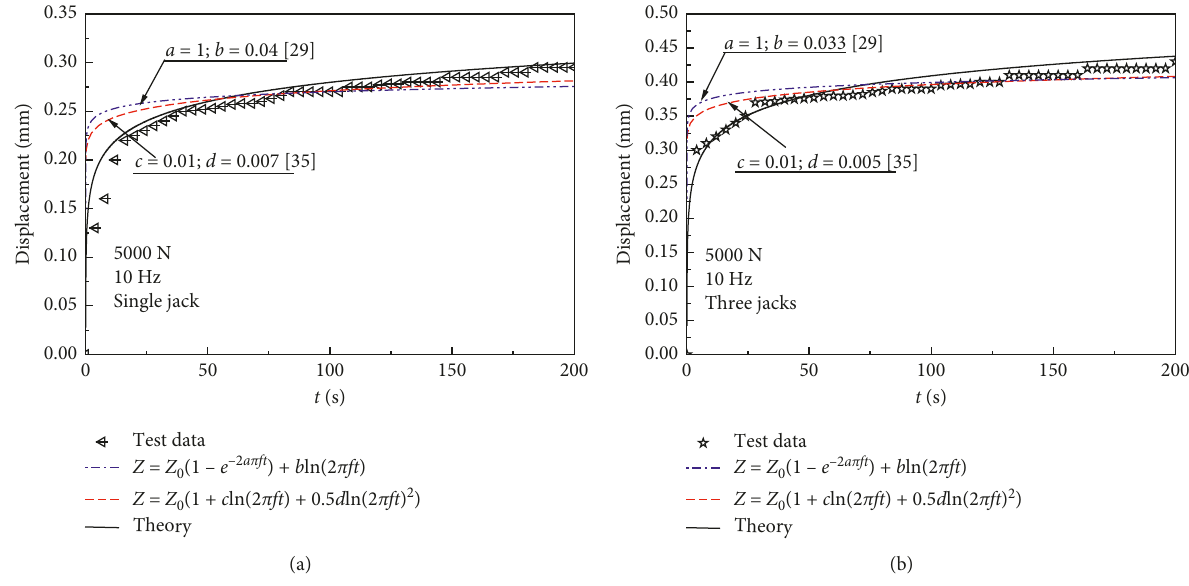
Figure 9: Variation in the displacement versus time curves (sand bag): (a) single jack and (b) three jacks.